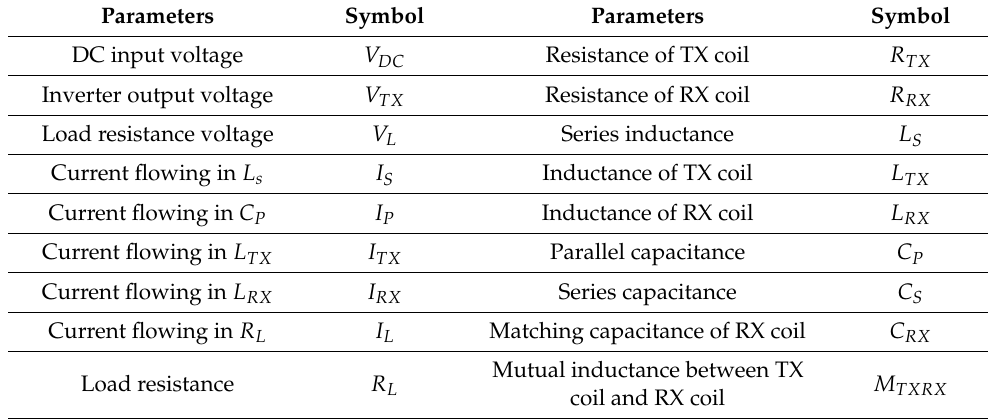
Figure 4. Simplified circuit of the proposed system. To generate constant current, the TX part uses an LCC topology, and the RX part uses a series topology to lower the complexity of the system. The circuit is shown from the DC input to the load. Table 1. Electrical parameters of the